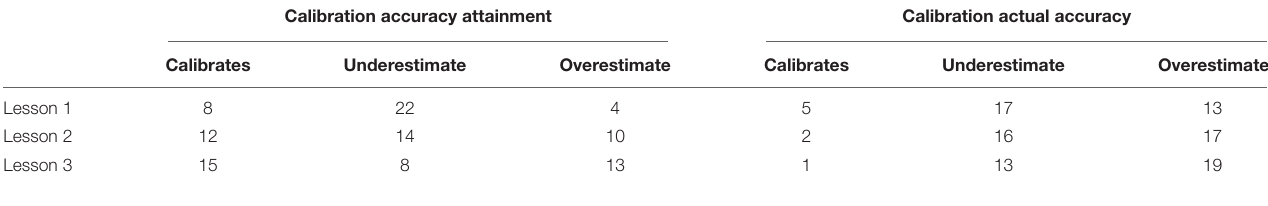
TABLE A2 | Correctness of the signals : overview of number of learners that calibrated, under or overestimated on accuracy attainment and accuracy. Calibration accuracy attainment